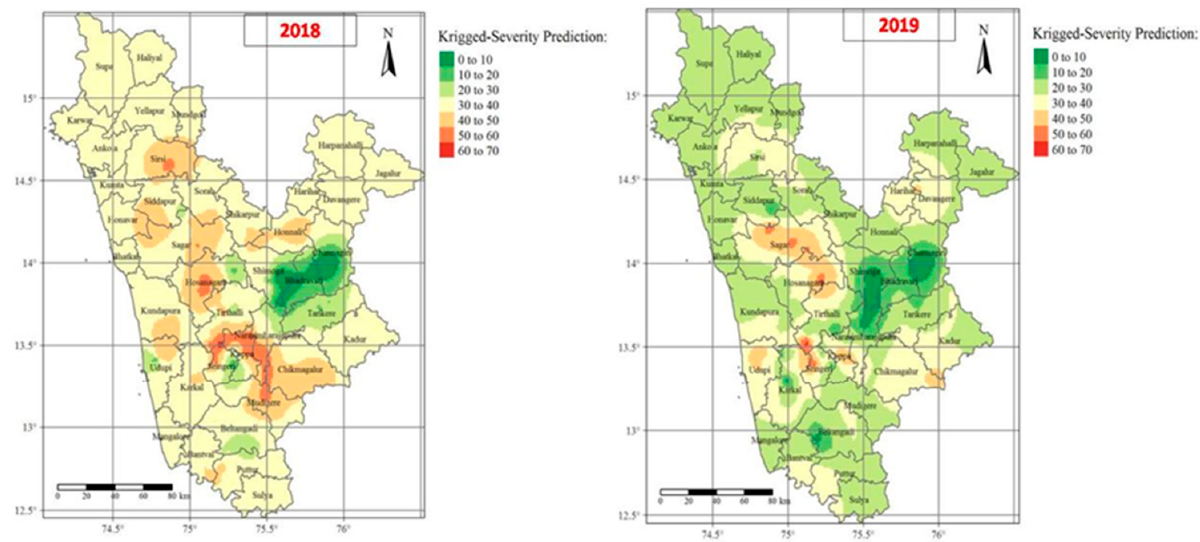
Figure 9. Interpolated maps representing distribution patterns of FRD in Karnataka during 2018 and 2019 using employing ordinary kriging (OK). Red to green color-coded surfaces depicts higher to lower FRD percent severity rates.